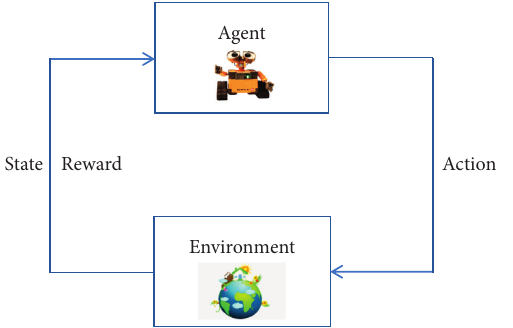
Figure 3: Schematic of reinforcement learning